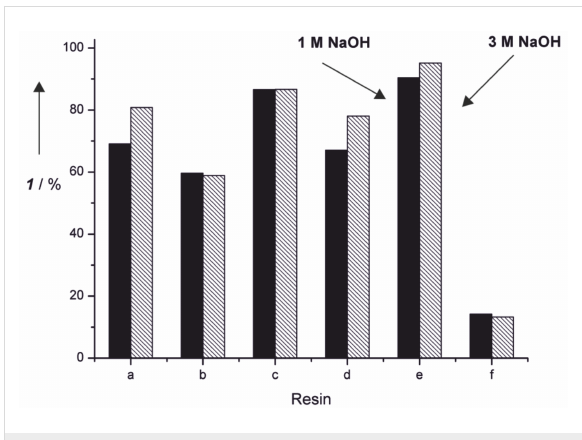
Figure 6: Amount of vanillin ( 1 ) removed by adsorption in a batch process at different strongly basic anion exchange resins. Experi- ments were performed at two different NaOH concentrations and desorption was realized by acidic treatment of the loaded resins.